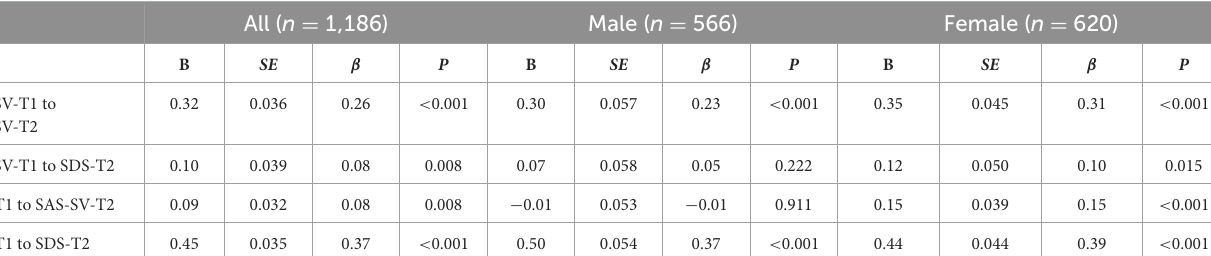
TABLE 4 Summary of the parameters for the whole sample, male and female of the CLPM.